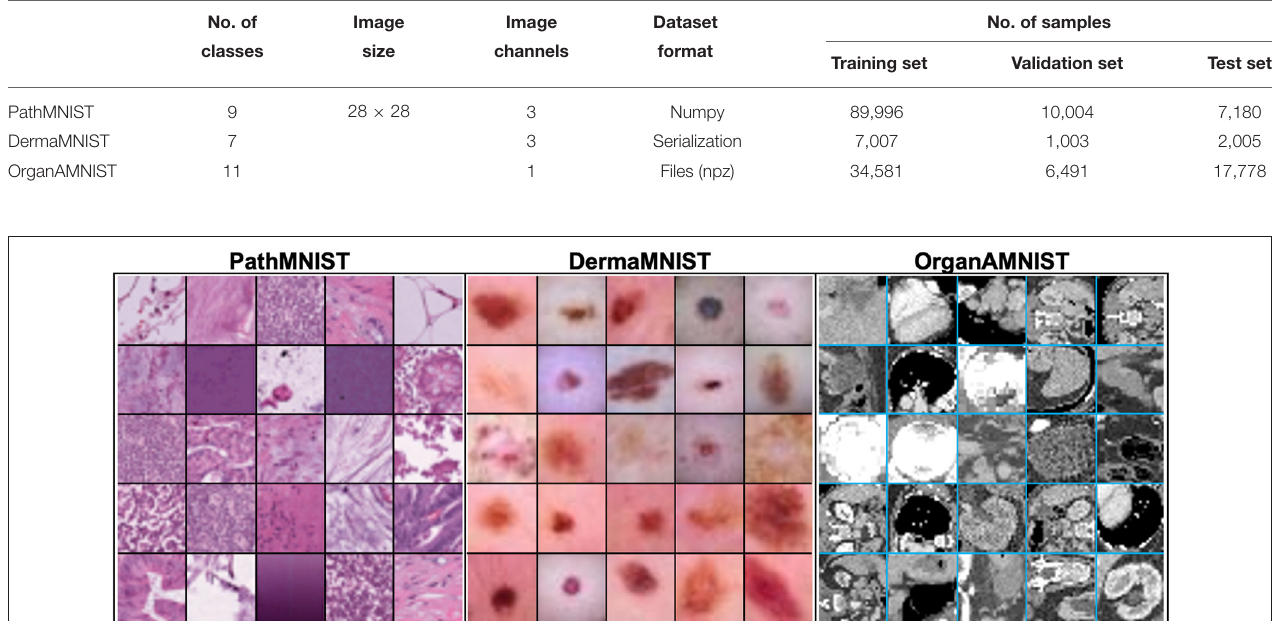
TABLE 3 | Summary of the datasets.